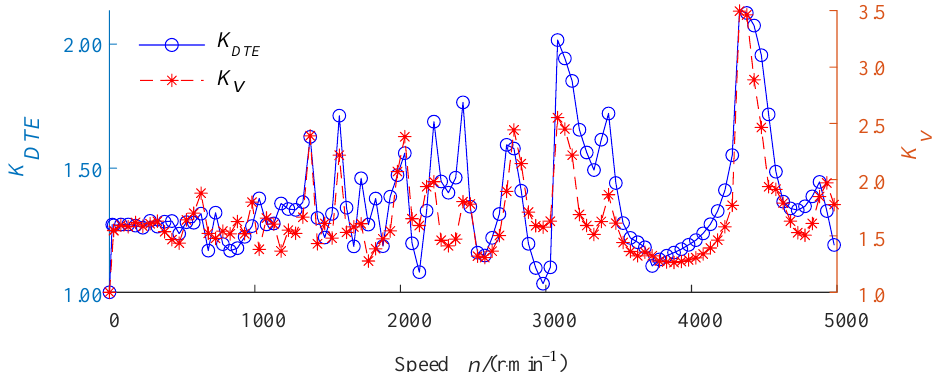
Figure 10. Relations between 𝐾 𝑣 and 𝐾 𝐷𝑇𝐸 for the steel gear pair.